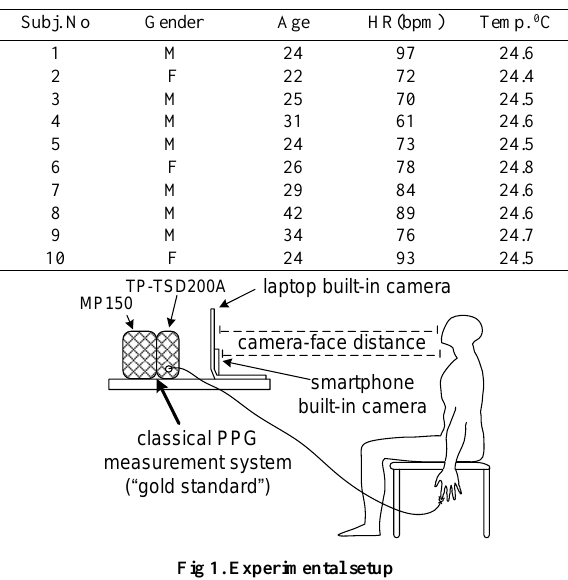
Table 1.Data for subject during the experiment: gender, age, heart rate, and ambient temperature